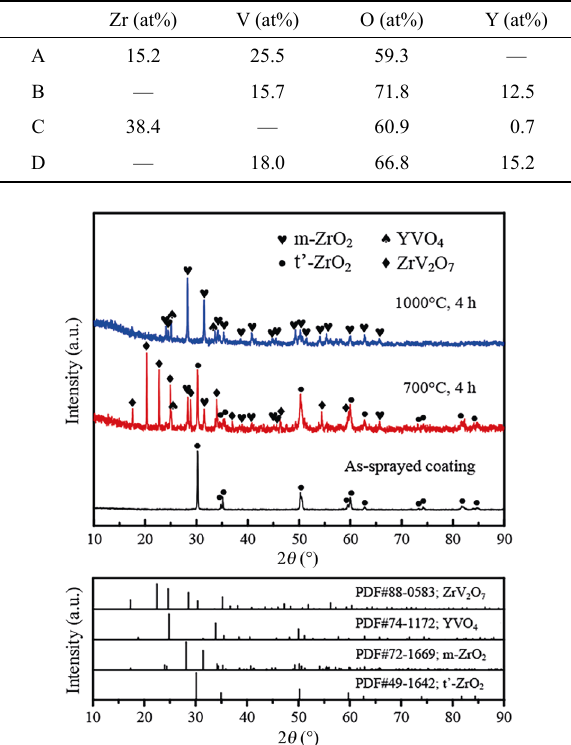
Fig. 6 XRD patterns of the as-sprayed YSZ coatings after hot corrosion tests. The standard PDF cards of ZrV 2 O 7 , YVO 4 , m-ZrO 2 , and t’-ZrO 2 are also